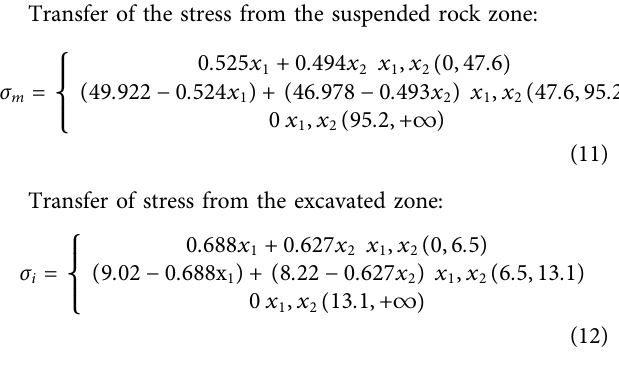
Frontiers in Earth Science |